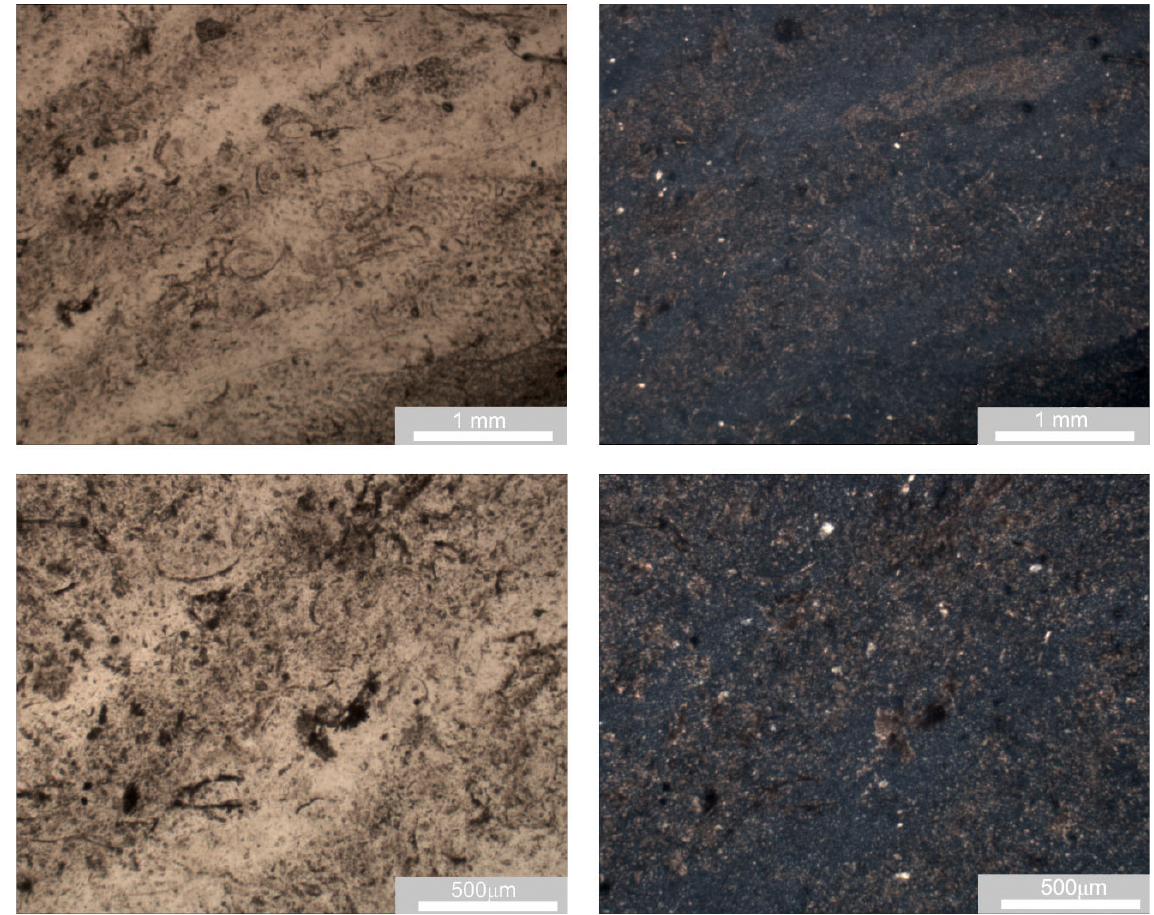
Figure 7. Xyloidal chert from the Picamoixons assemblage. Left: Images with plane polarizer where the primary depositional texture and Liesegang rings can be seen. Right: Crossed polarised light reveals the presence of micro- and cryptoquartz as well as detrital